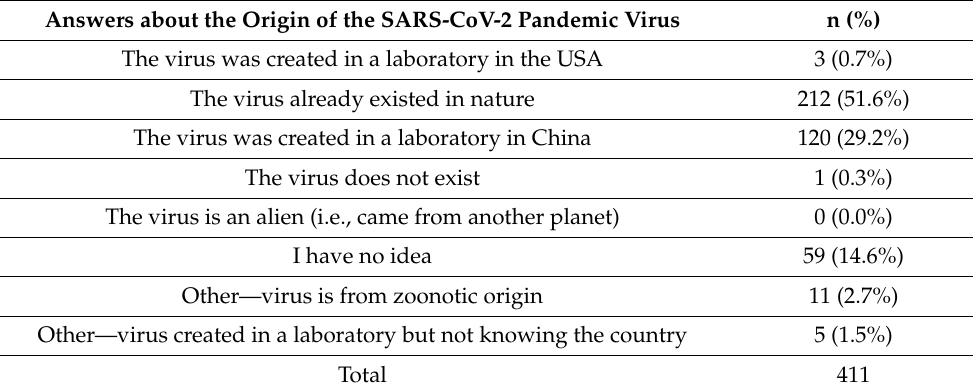
Table 1. Answers about the origin of the SARS-CoV-2 pandemic virus. Answers about the Origin of the SARS-CoV-2 Pandemic